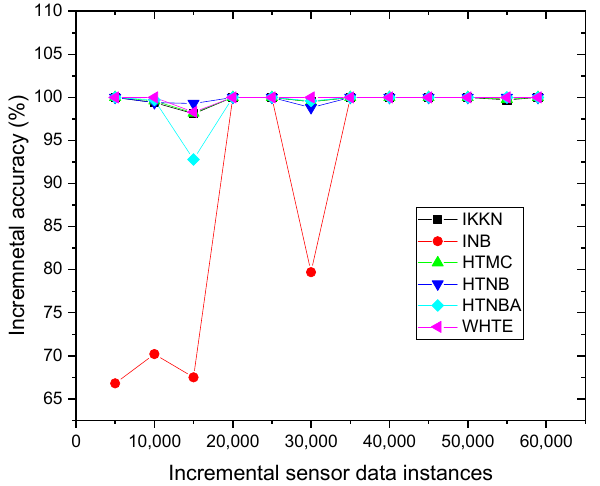
Figure 6. The incremental accuracy of the applied methods for each subset of data samples per slide window for the GPS-tracker sensor dataset.